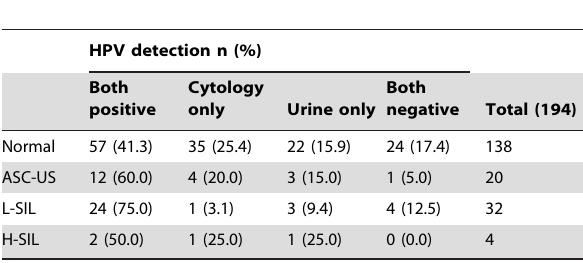
Table 2. HPV detection in both sample sources according to the cytological